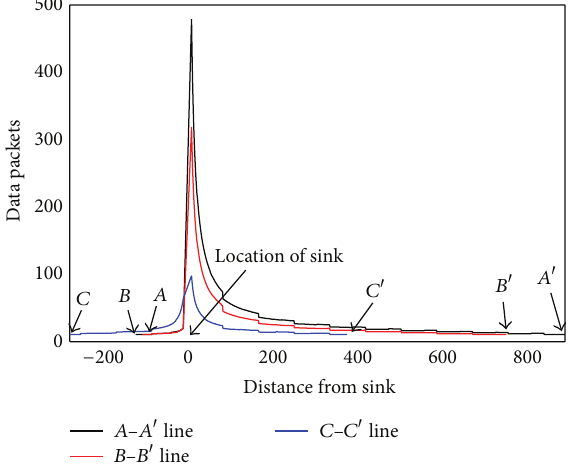
Figure 4: Selected 𝐴𝐴 󸀠 , 𝐵𝐵 󸀠 , and 𝐶𝐶 󸀠 positions.